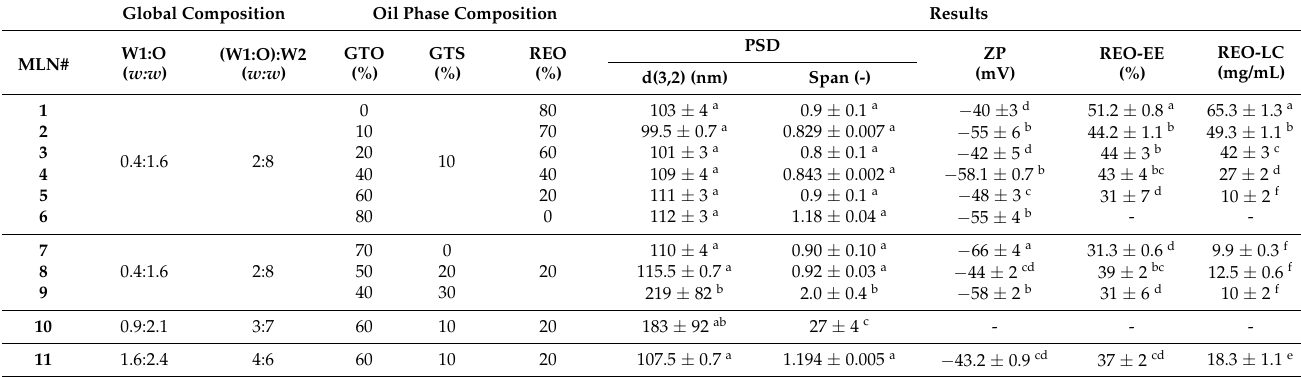
Table 2. Effect of mass phase ratios and lipid composition on MLN physicochemical properties. Global Composition Oil Phase Composition